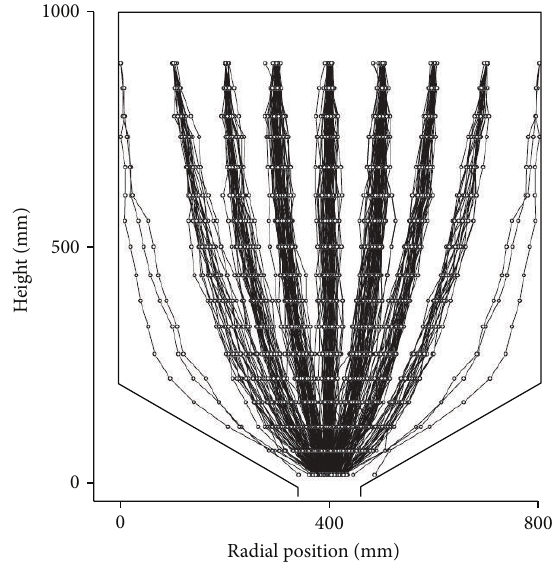
Figure 3: Descending tracks of tagged